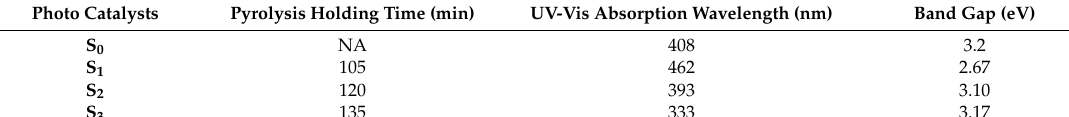
Table 4. Effect of pyrolysis time under N 2 gas at 350 °C and ramping rate of 50° C/min on the band Table 4. E ff ect of pyrolysis time under N 2 gas at 350 ◦ C and ramping rate of 50 ◦ C / min on the band gap of the synthesised C–N–TiO 2 nano catalysts (S 0 = with Degussa TiO 2; S 1 = C–N–TiO 2 105 min;